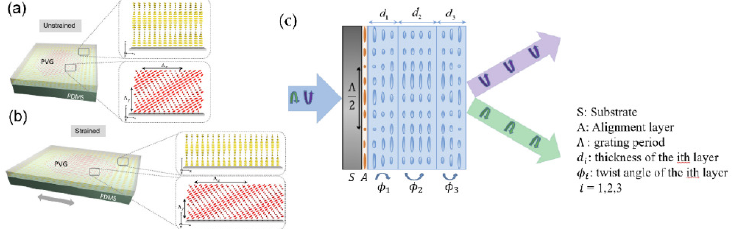
Figure 17. Schematic illustrations of the PVG structure and stretching process of PVG from an unstrained state to strained state. ( a ) PVG on PDMS without strain. ( b ) Strained PVG structure [90]. ( c ) Three-layer twisted structure PB phase control beam deflector [85]. Reprinted with permission from Ref. [90,85]. 2019 The Optical Society.